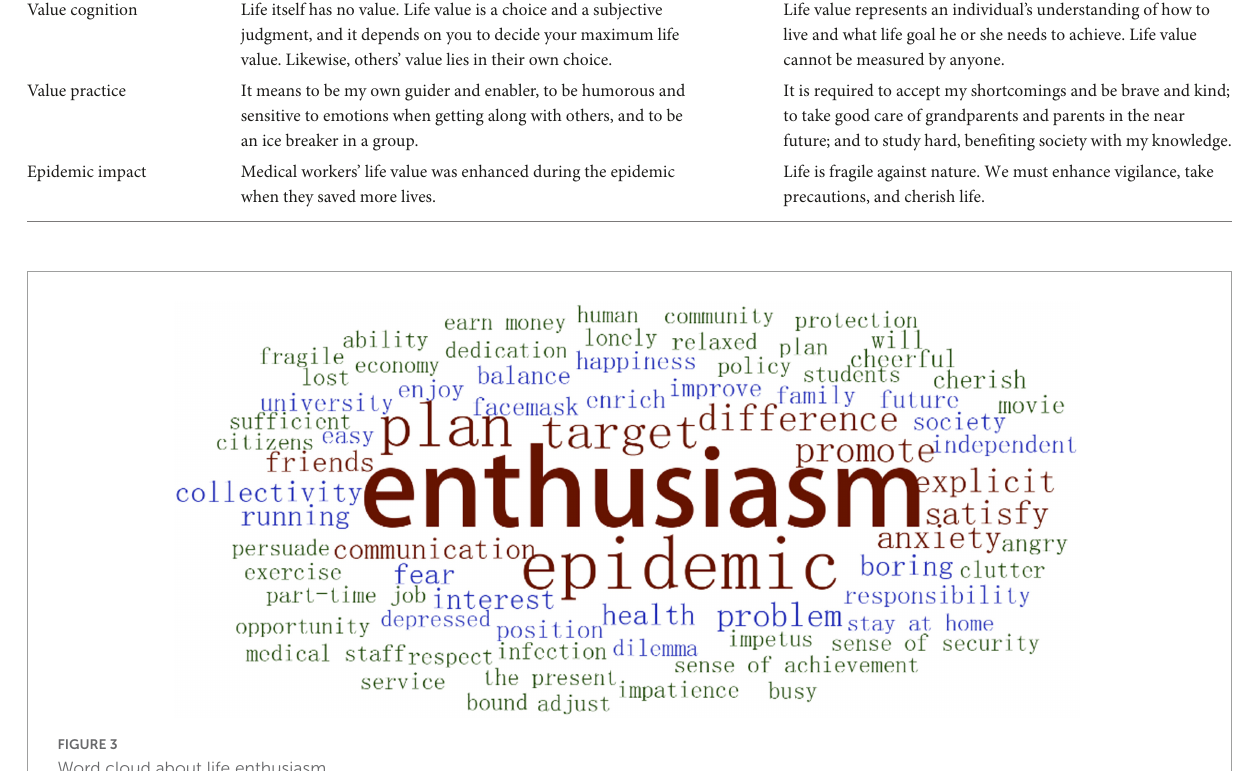
FIGURE3 Word cloud about life